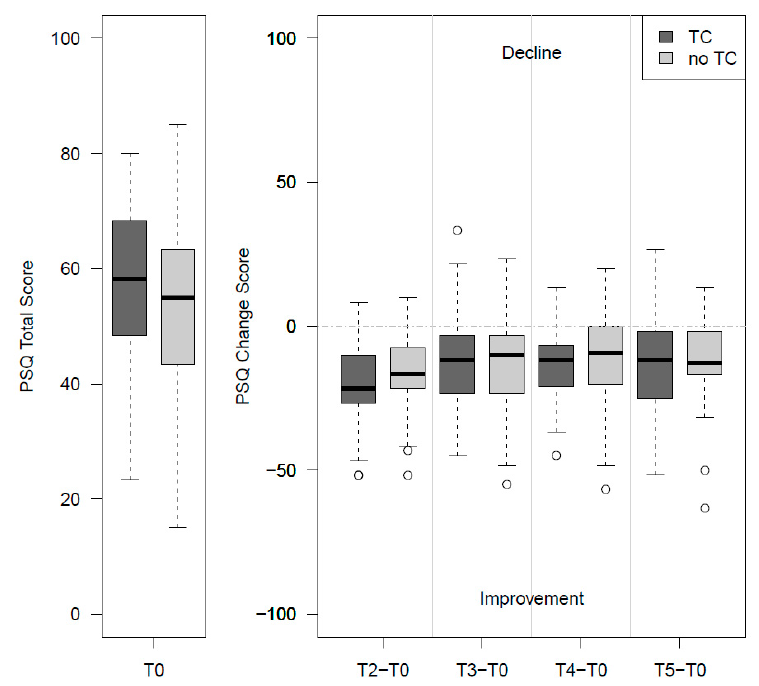
Figure 2. Perceived stress at baseline and change in score over time—TC ( n = 51) versus noTC ( n = 52). TC: telephone-coaching group; noTC: control group without telephone-coaching; PSQ: Perceived Stress Questionnaire; T0: baseline; T2, T3, T4, T5: 1-, 3-, 6-, and 9-month follow-up.